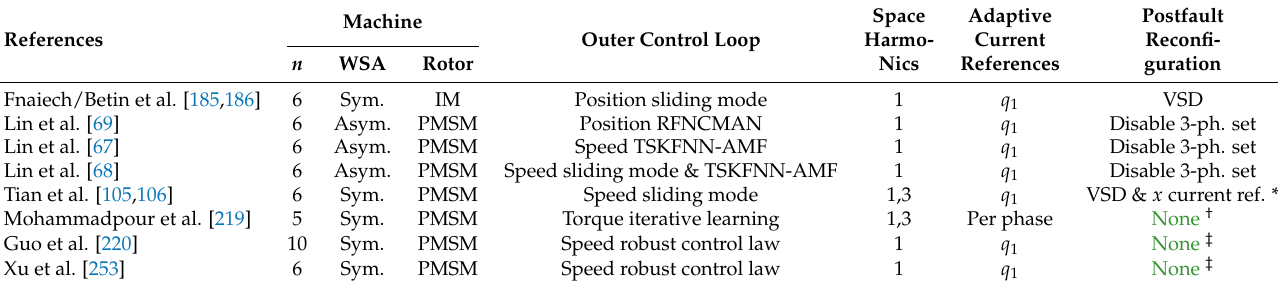
Table 15. Methods for generating current references under phase OCs by adaptive outer control loop (Section 3.5.3) in multiphase applications in the